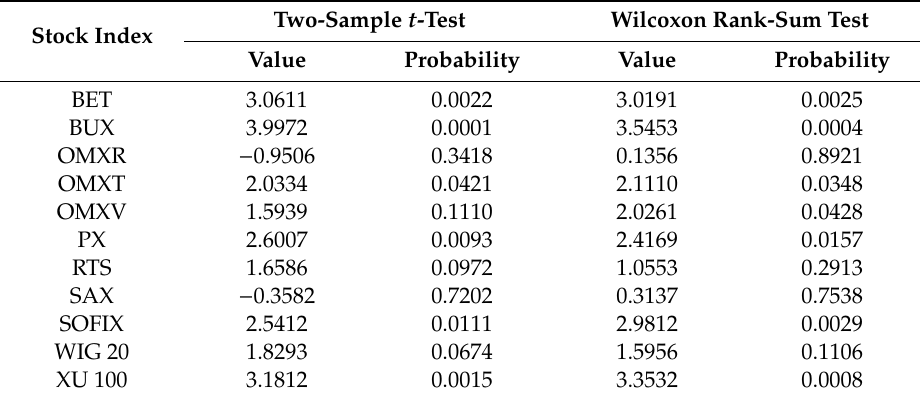
Table 4. Results of the statistical significance tests—Turn of the month window (3 +